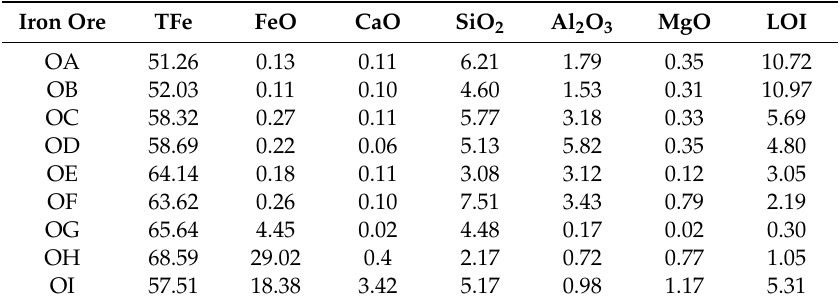
Table 1. Chemical composition of 0.5-mm iron ore fines